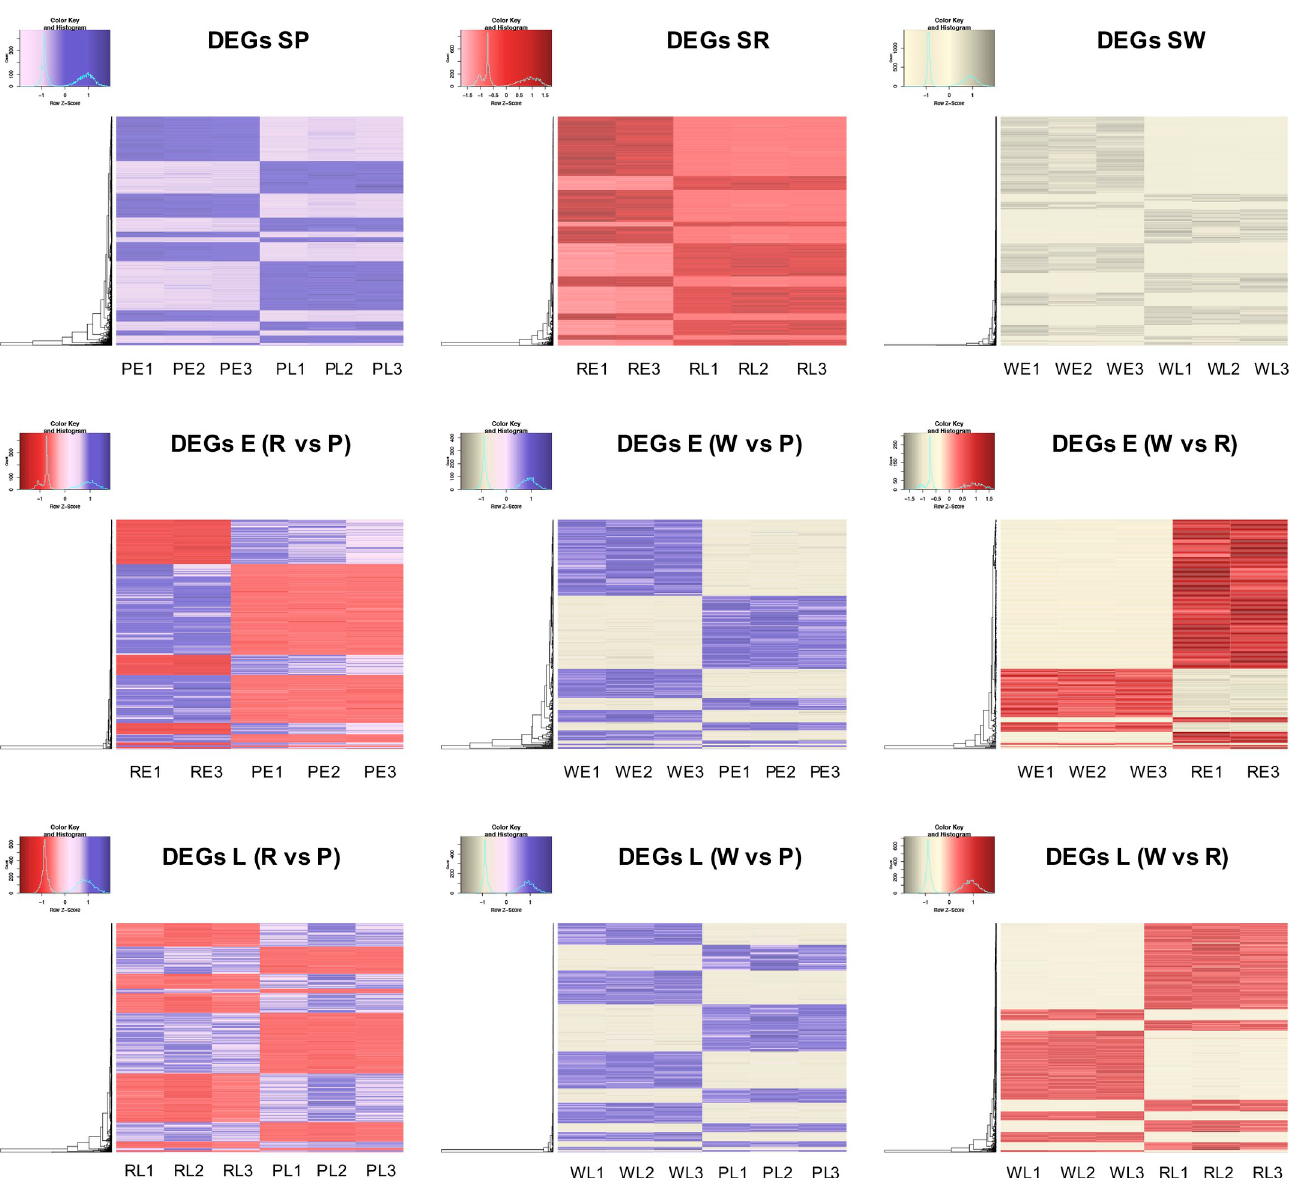
Fig 5. Heat map of RNA-Seq transcriptome analysis for 8,324 selected genes from the Anthurium andraeanum . For each illustration: S: stage, W: white, R: red, P: purple; and for stages: E: early, L: late. The biological replicates for each combination of the color stages are indicated with numbers (1,2,3). Only genes with log fold change (logFC) � 2 and at an FDR < 5x10 -4 are represented in the heatmaps. In figures, lighter colors correspond to under-expressed genes and darker colors to over-expressed